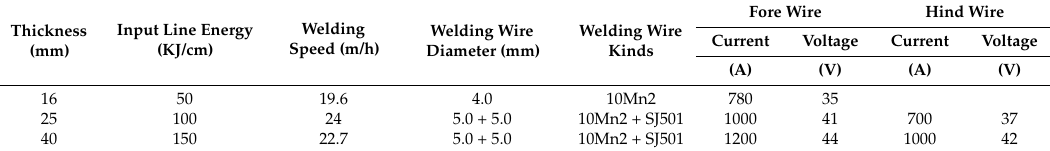
Table 2. Welding parameters.